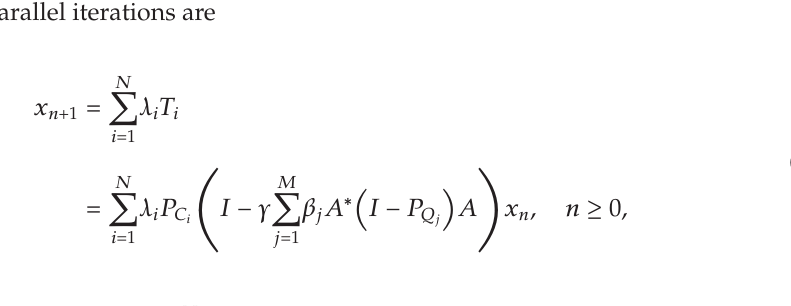
Algorithm 3.5. Cyclic iterations